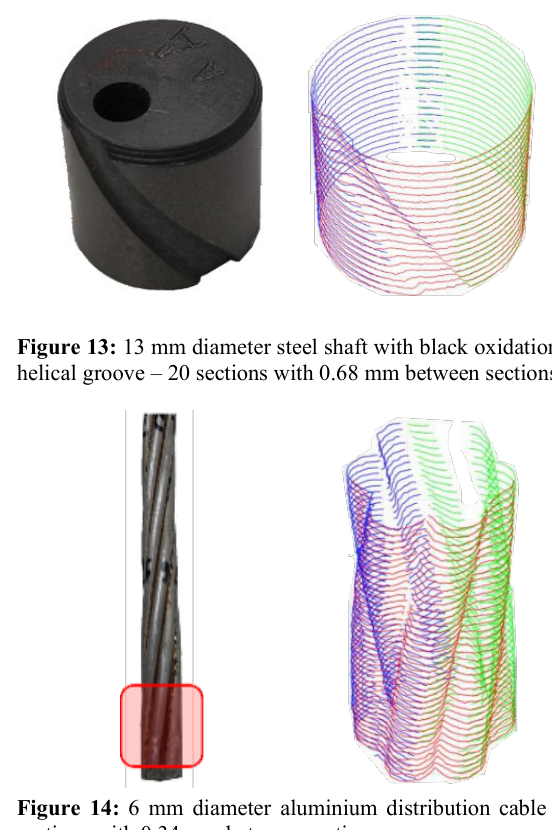
Figure 12: 22 mm diameter aluminium pipe with undulations – 26 measured sections with 0.68 mm displacement between sections.